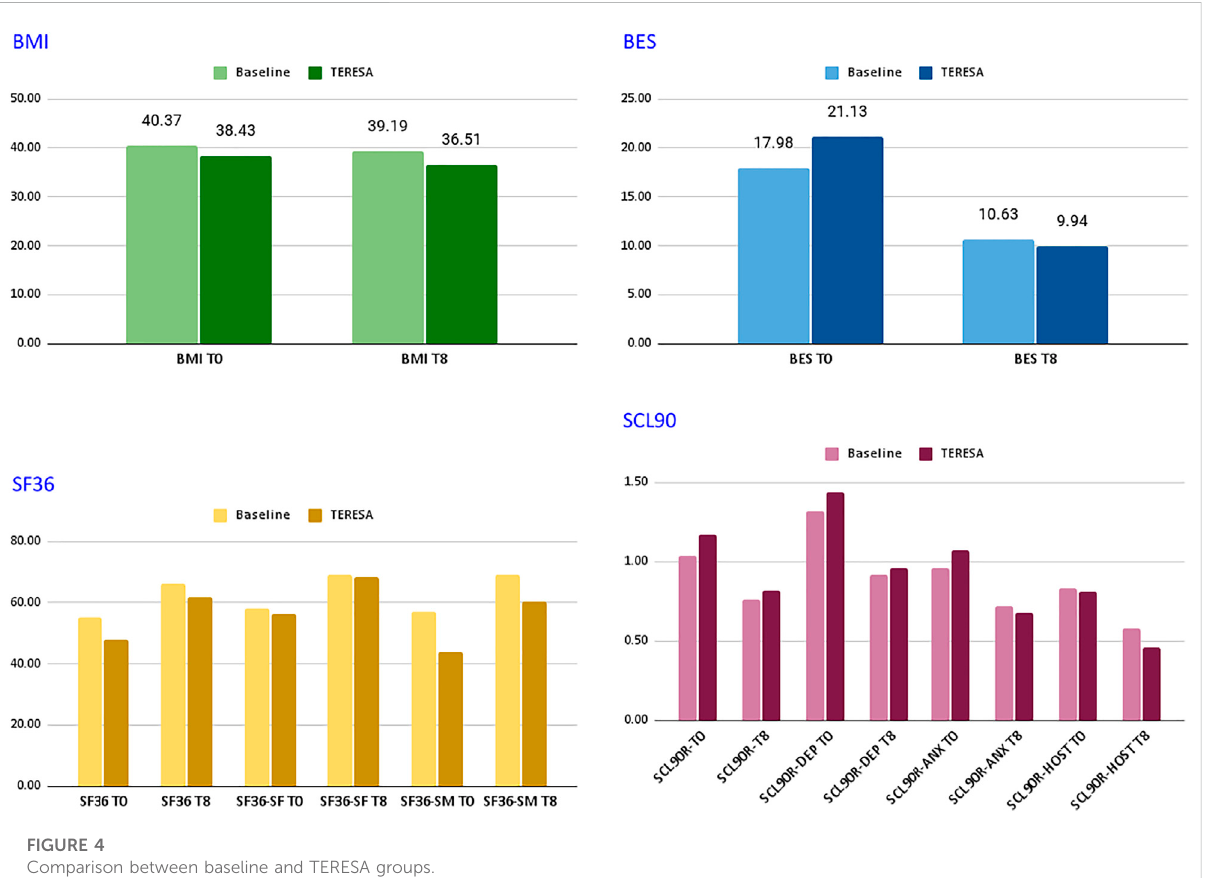
FIGURE 4 Comparison between baseline and TERESA groups.